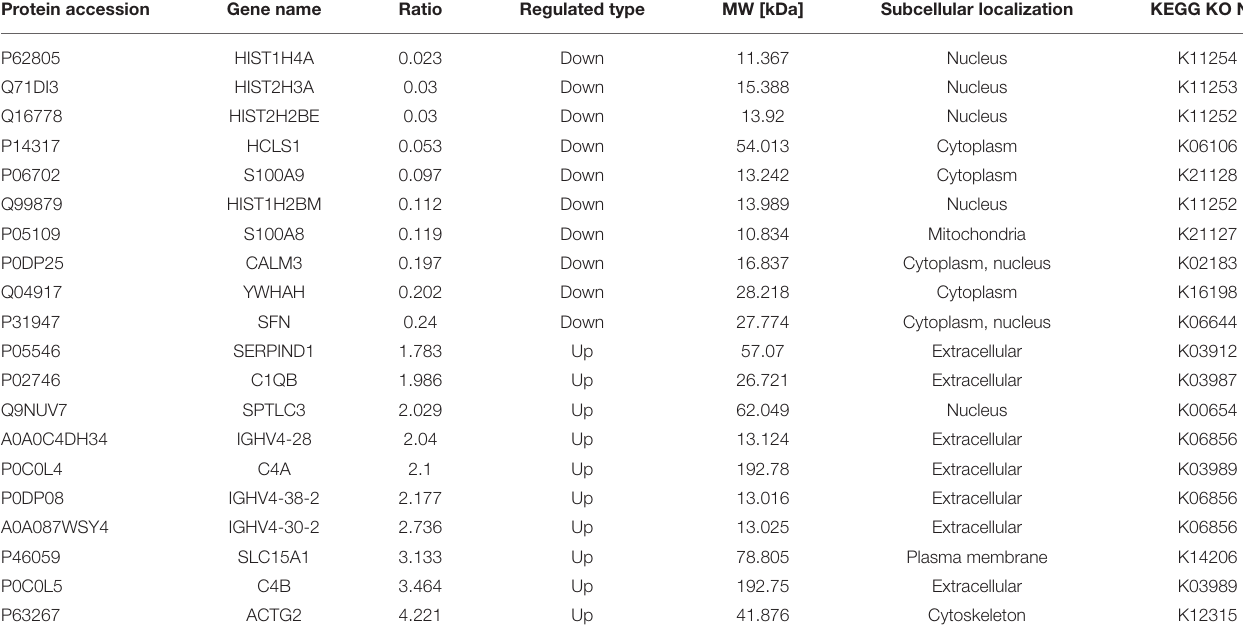
TABLE 2 | Top10 differentially expressed proteins and details. Protein